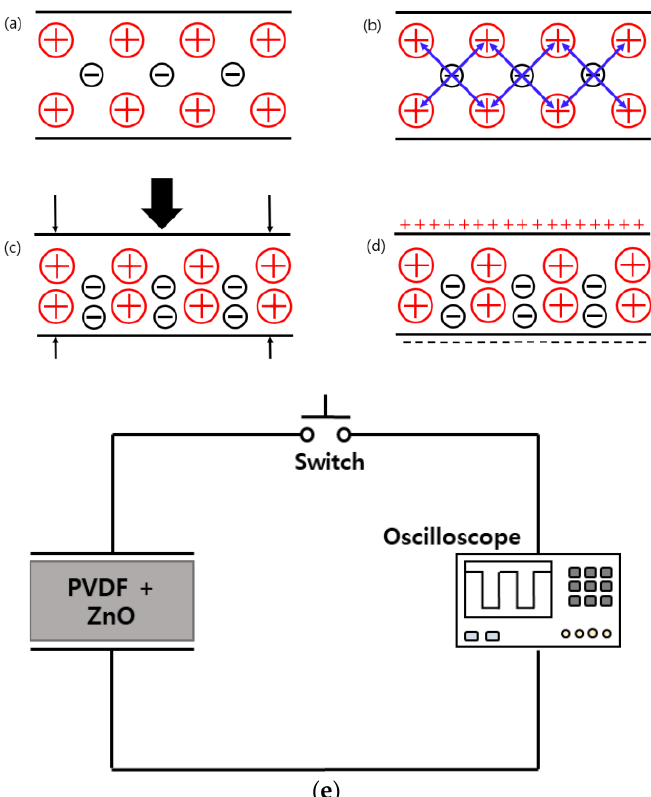
Figure 3. ( a – d ) Working principal of piezoelectric sensor, ( e ) electrical setup of nanogenerator with oscilloscope.